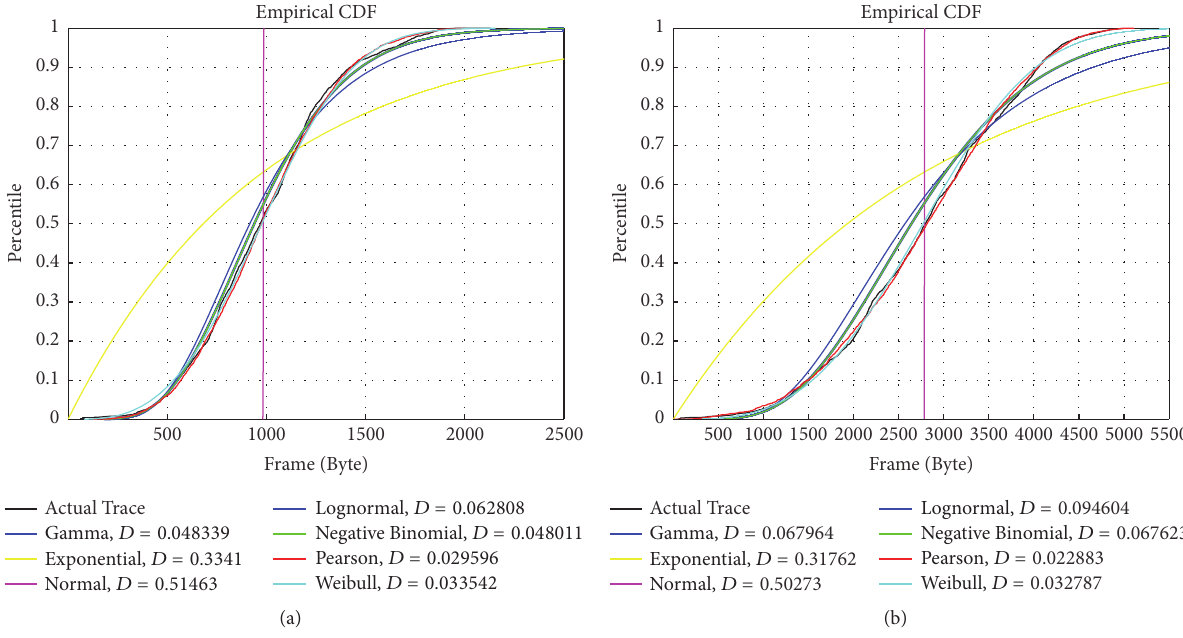
Figure 4: (a) The K-S test of the frame size of I frames in the NBC News base layer and (b) the K-S test of the frame size of I frames in the NBC News enhancement